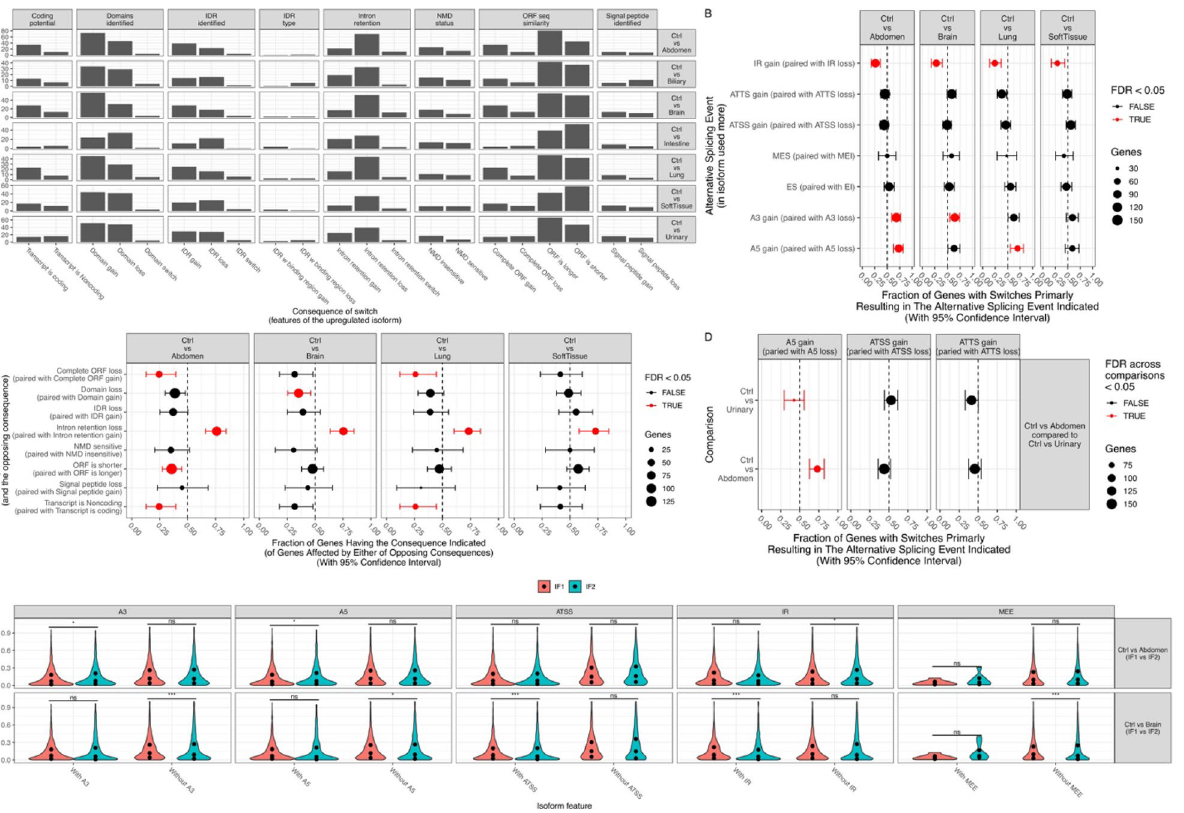
Figure 3. Consequences of isoform switching across different types of sepsis. ( A ) The number of isoform switching consequences associated with different sepsis types. ( B ) Enrichment analysis exploring the uneven distribution of opposite alternative splicing events. The fraction of genes with switching primarily resulting in an alternative splicing event is indicated. ( C ) Enrichment analysis exploring the uneven distribution of opposite switching consequences. ( D ) Comparison of differences in the fraction of alternative splicing events in patients with abdominal sepsis compared to those with urinary tract sepsis. ( E ) Isoform expression between the patients with sepsis of the abdomen and brain and the controls. dIF difference in the isoform fraction; FDR false discovery rate; IR intron retention, IDR intrinsically disordered regions, NMD nonsense-mediated decay, ORF open reading frame, IR intron retention. A5 alternative 5 ′ donor site (changes in the 5 ′ end of the upstream exon) , A3 alternative 3 ′ acceptor site (changes in the 3 ′ end of the downstream exon) , ATSS